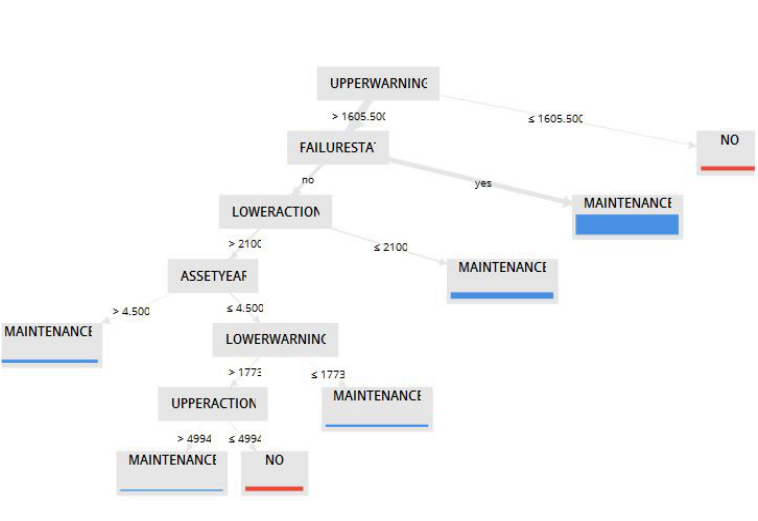
Fig. 10. Decision Tree